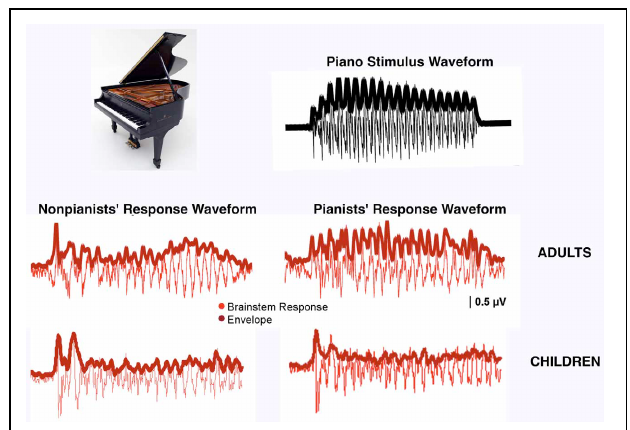
FIGURE 4 | Timbre specialization among musicians. Adult pianists’ auditory brainstem responses more closely reflect the amplitude envelope of the piano stimulus than non-pianists’ ( F = 6 . 97, p < 0 . 01), demonstrating preferential encoding for the sound of their instrument of practice (adapted from Strait et al., 2012a). Child pianists do not demonstrate preferential encoding of their instrument compared to non-pianists ( F = 0 . 04, p = 0 . 85), perhaps indicating insufficient musical training to support